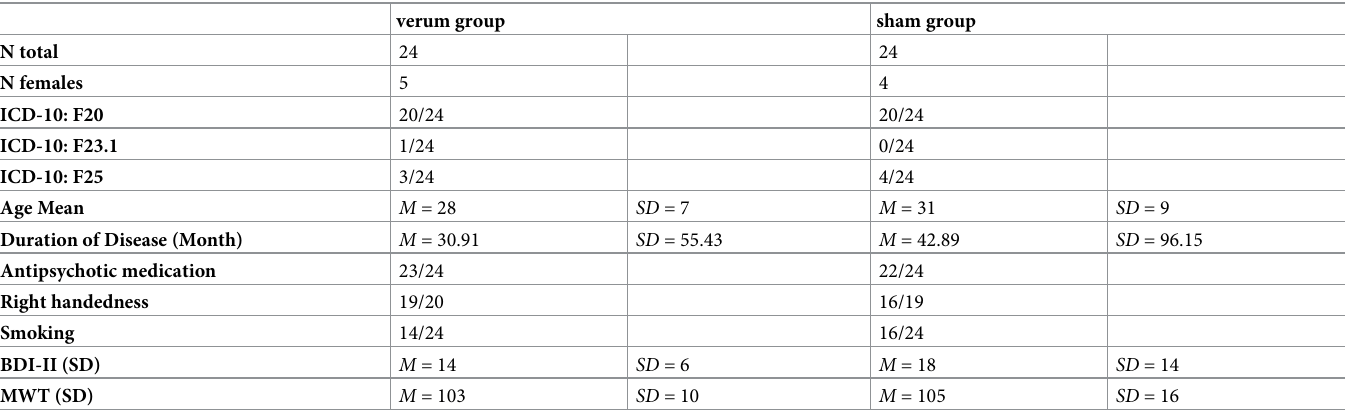
Table 1. Demographic and clinical data.